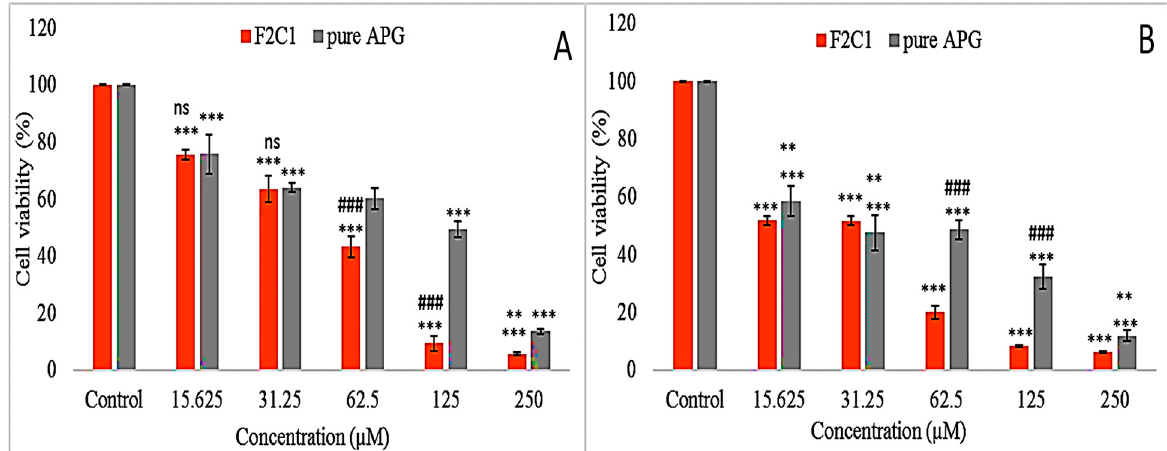
Figure 7. Cell viability studies of pure apigenin and chitosan-coated apigenin bilosomes (F2C1) against ( A ) lung cancer cell line A549 and ( B ) breast cancer cell line MCF7. Results depicted as mean ± SD ( n = 3). Tukey Kramer test was used to compare different groups. *** highly significant compared to control, ** significant compared to pure APG, ### highly significant compared to pure APG, ns—non-significant.